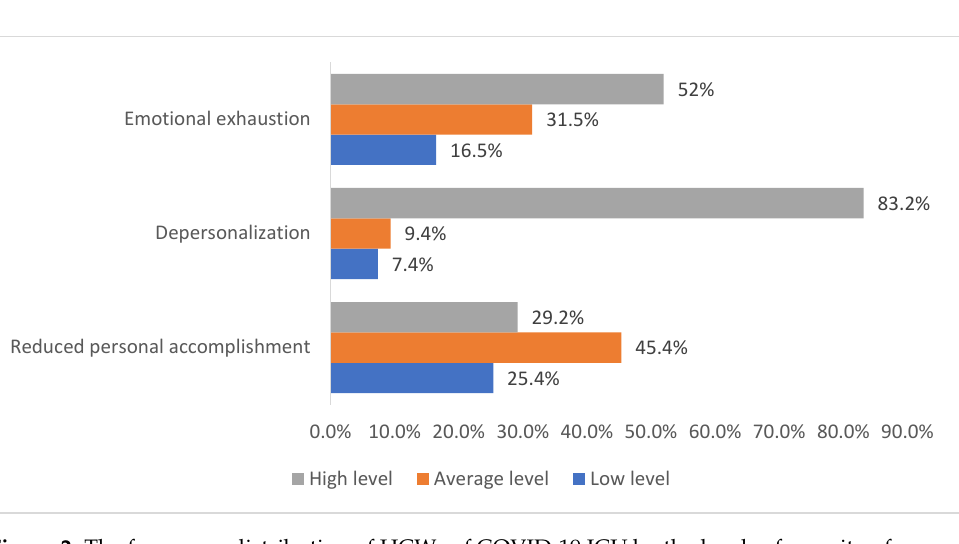
Figure 2. The frequency distribution of HCWs of COVID-19 ICU by the levels of severity of occupa- tional burnout